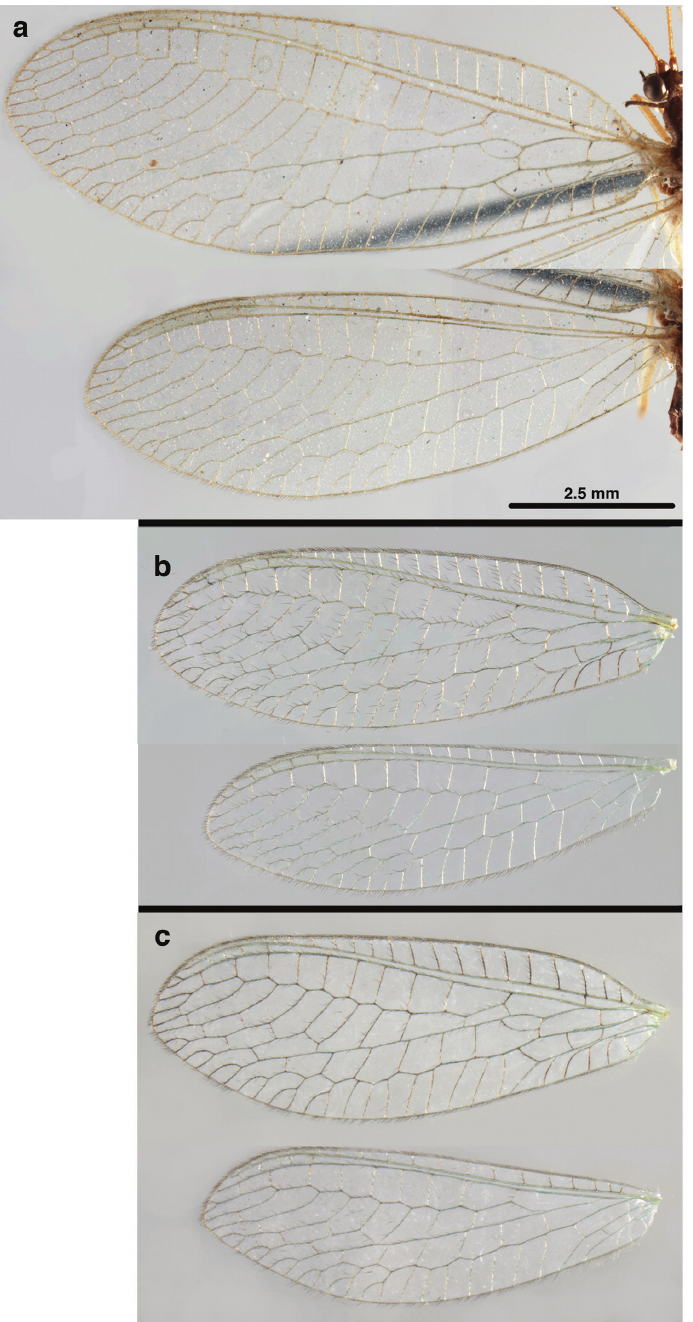
Figure 138. Wings of three Ungla species from Argentina (all: same scale), ( a ) Ungla steinbachi (Navás) ( b ) Ungla chacranella (Banks) ( c ) Ungla confraterna (Banks). (Argentina; a Tucumán, lectotype of Chrys- opa steinbachi , female, ZMB; b La Rioja, male, FSCA; c La Rioja, male,